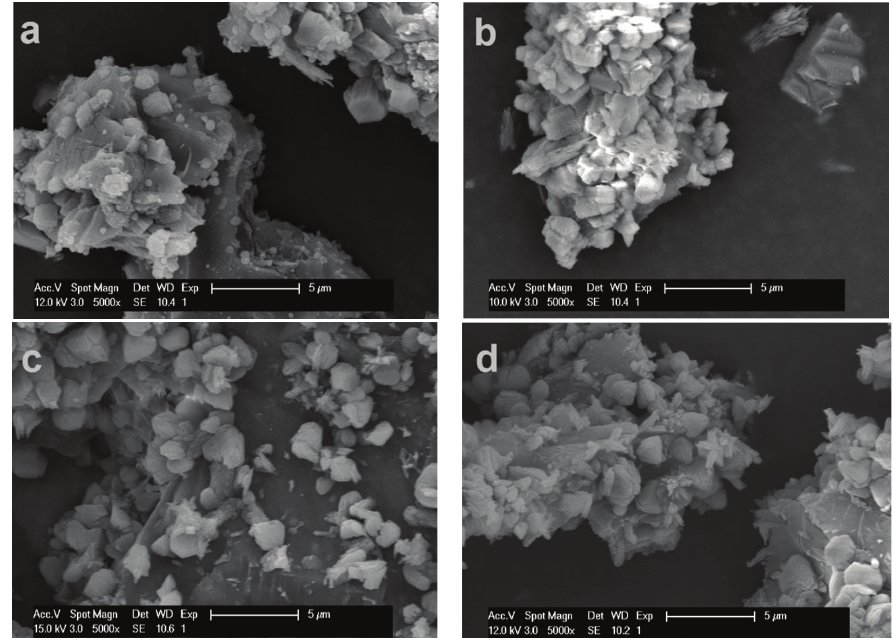
Figure 7: Morphology of AOD slag, carbonated for one hour, at 50 ∘ C and 50g/L, with mechanical stirring, without NiNP addition (a) and with NiNP addition (b); morphology of CC slag, carbonated with the same parameters, without NiNP addition (c) and with NiNP addition (d), realized by SEM